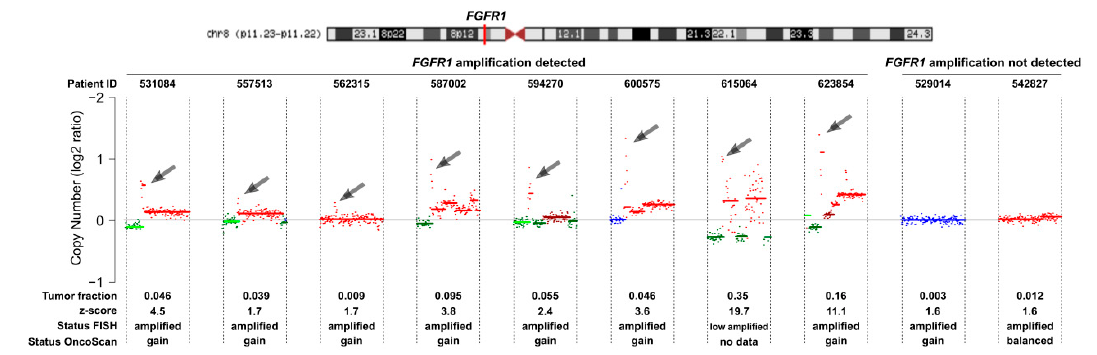
Figure 3. Copy number status of chromosome 8 of cell-free DNA (cfDNA) samples established with shallow whole-genome sequencing (sWGS). The log-2 ratios of chromosomes 8 of plasma samples from 10 metastatic breast cancer patients with FGFR1 amplification in their tumors are plotted. In 8 of those, the FGFR1 amplification could also be detected in plasma (right panel), whereas in 2 cases, the amplification could not be detected most likely due to a low tumor content. The gain of chromosomal regions is indicated in red, losses are shown in green, and balanced regions are shown in blue. Tumor fraction estimated from ichorCNA, z-score, FISH, and Oncoscan status is indicated.